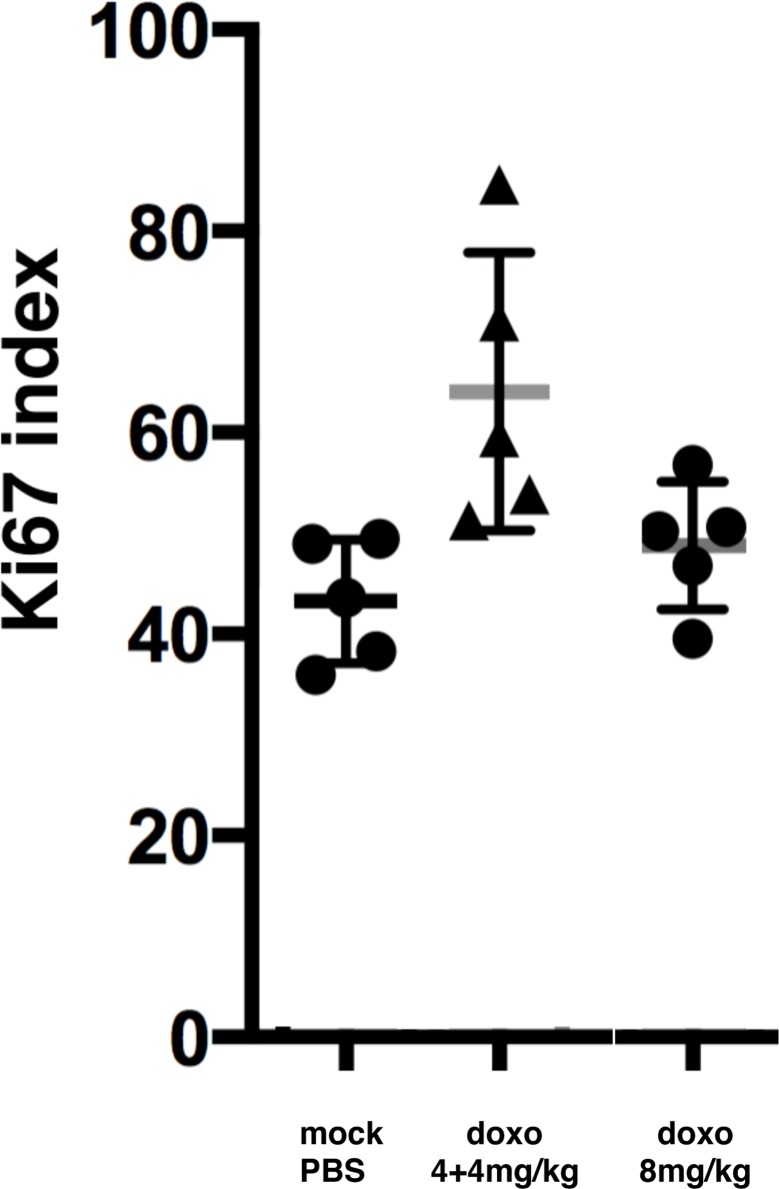
Percentage Ki67 positive cells in BE(2)-C tumour following doxo treatment in the PSCT model.Fraction of cells (%; mean±SD) expressing Ki67 96 hours after indicated treatments. Mock = diluent (1xPBS). Data based on 5 PSCT per group. For statistical analysis, see text.